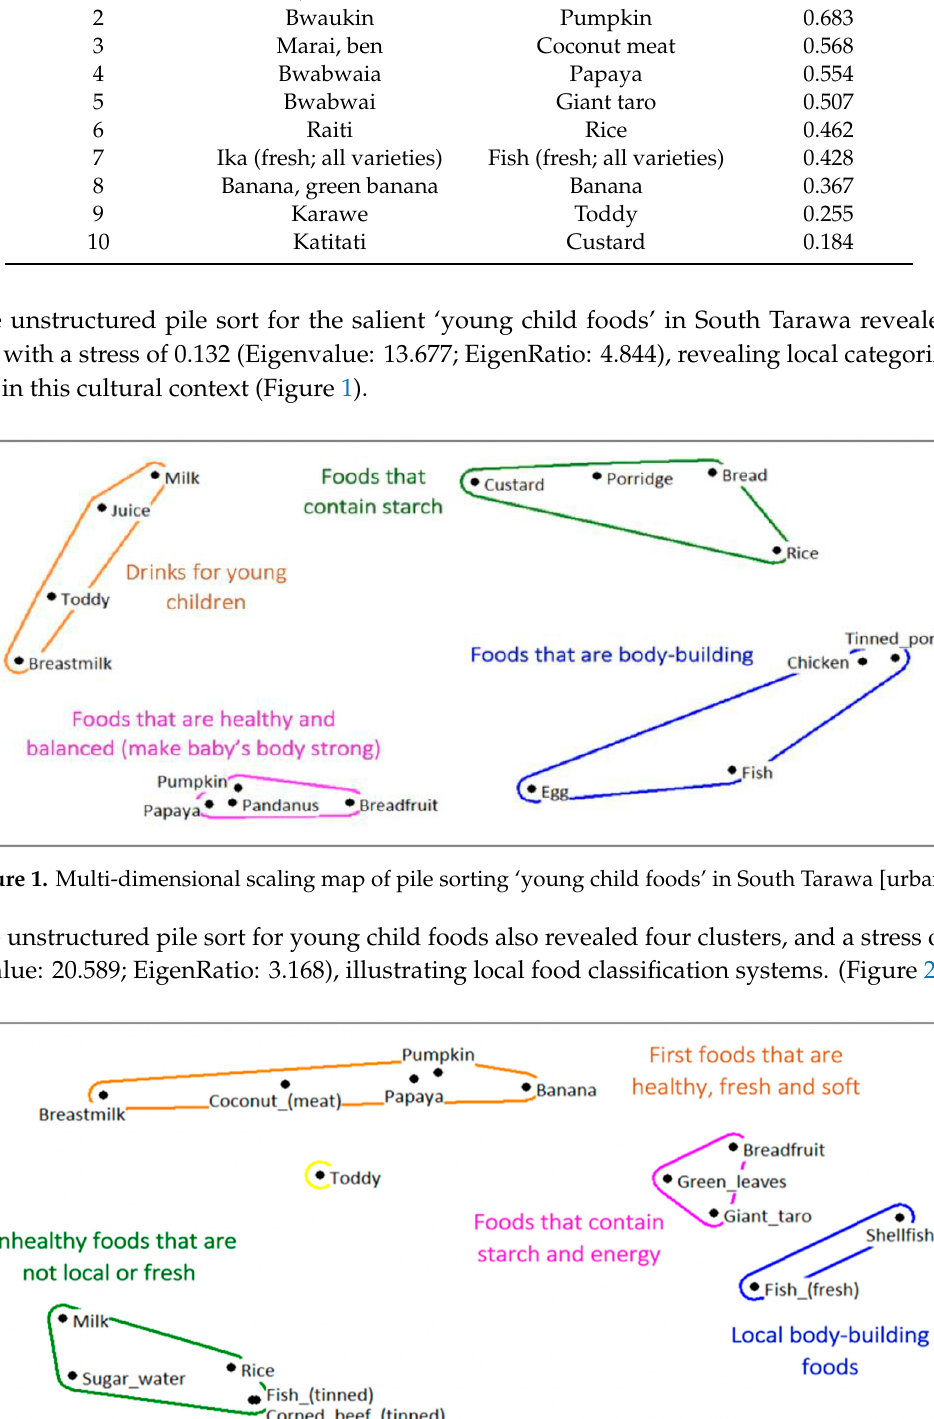
Table 8. Salient young child foods from free lists among caregivers in Butaritari [rural].